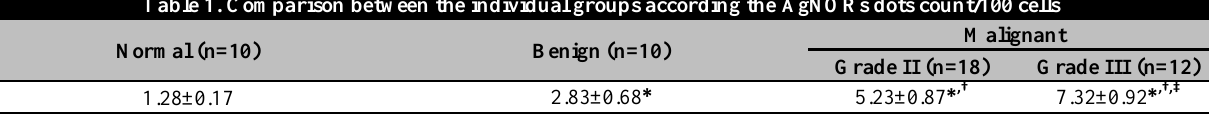
Values expressed as mean ± standard deviation.* p<0.001 compared to normal group. † p<0.001 compared to benign group. ,‡ p<0.001 compared to malignant grade II